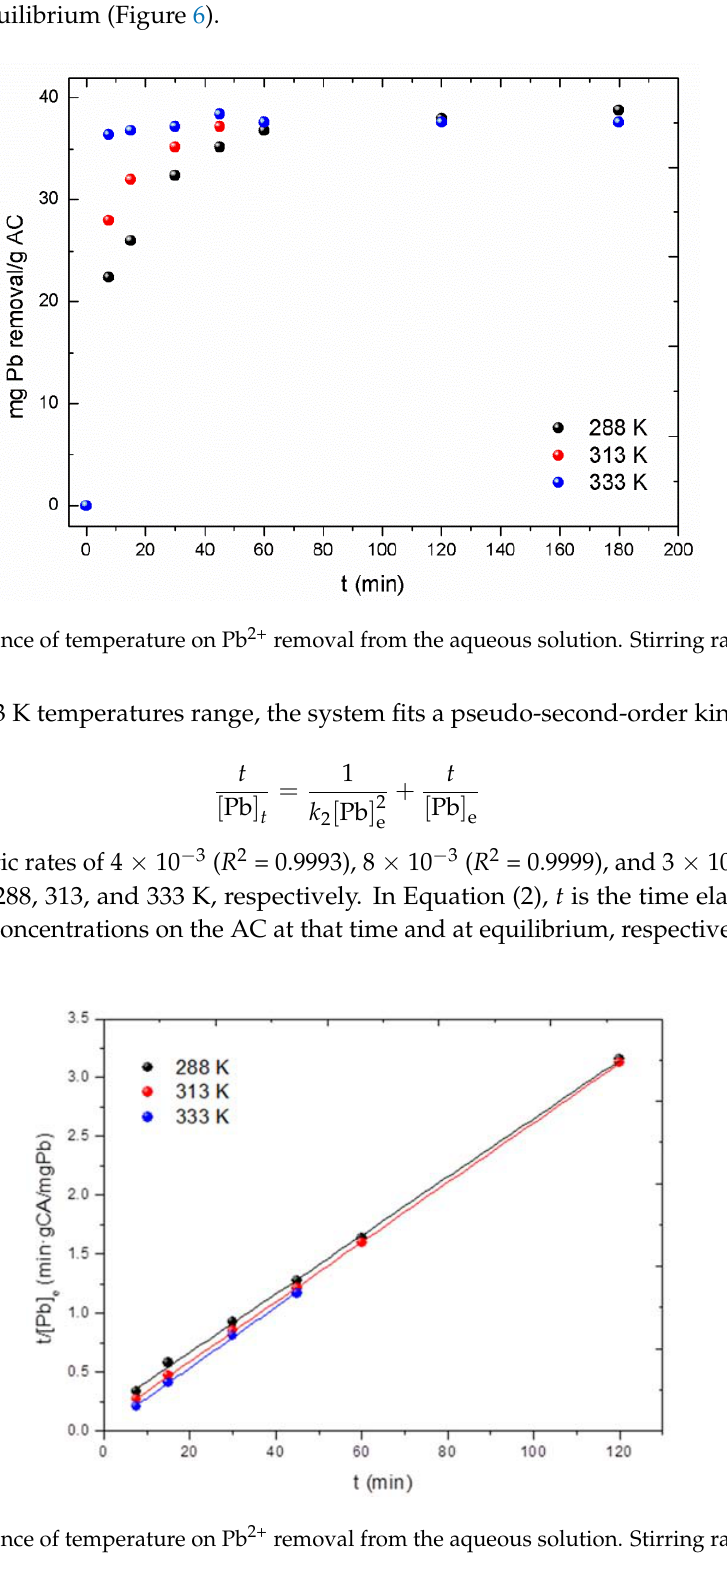
Figure 7. Influence of temperature on Pb 2+ removal from the aqueous solution. Stirring rate: 750